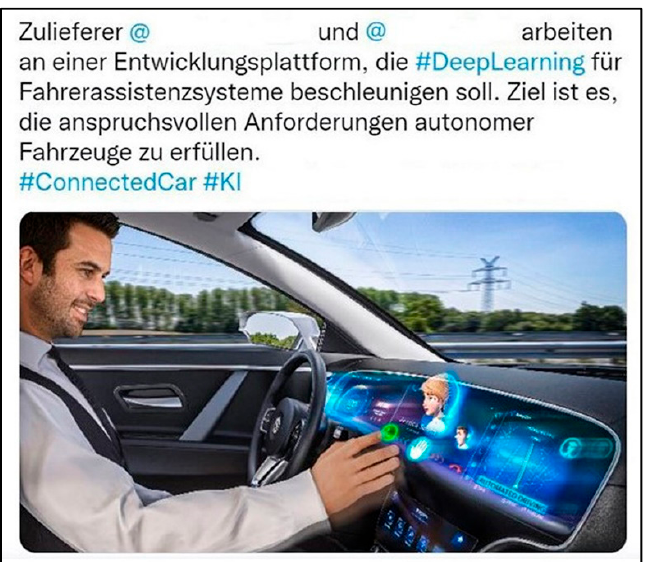
Figure 8. Statement about the development of new systems.